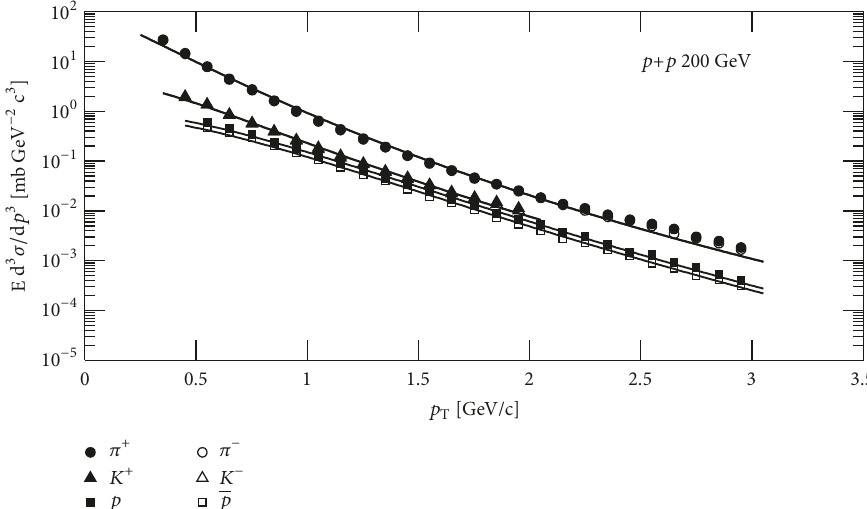
Figure 2: The transverse momentum distributions of 𝜋 + , 𝜋 − , 𝐾 + , 𝐾 − , 𝑝 , and 𝑝 produced in 𝑝 + 𝑝 collisions at √ 𝑠 = 200 GeV at midrapidity. The solid dots, solid triangles, solid squares, circles, triangles, and squares represent the experimental data of the PHENIX Collaboration [45]. The solid curves are the results calculated from Equation (19).